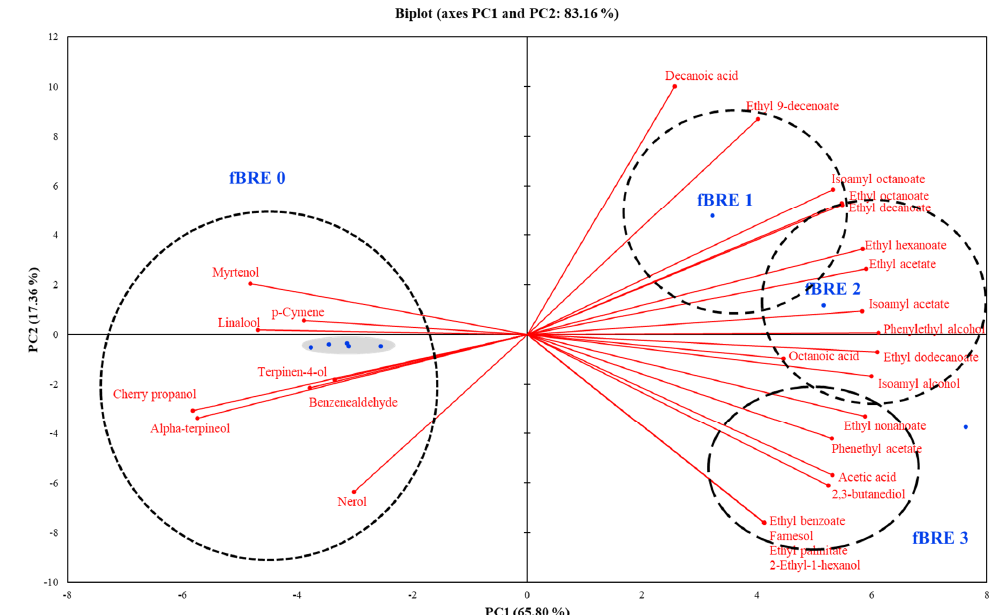
Figure 5. Biplot of the principal component analysis of volatile compounds from fermented black raspberry extract beverage inoculated with Pediococcus acidilactici M76.